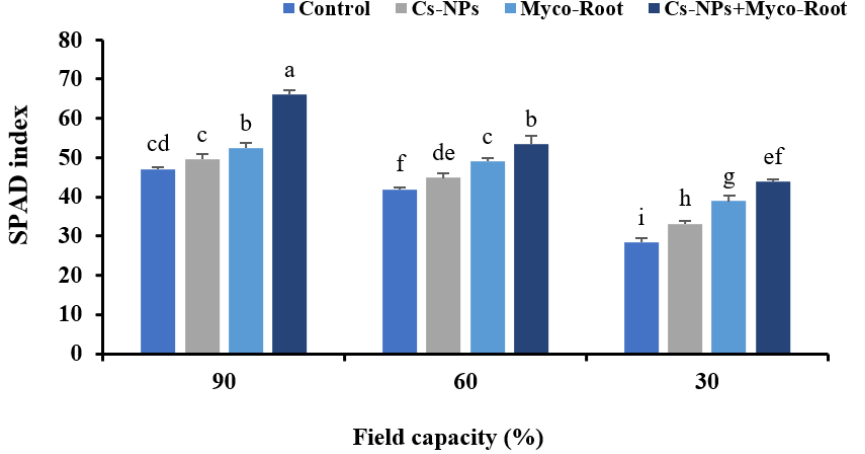
Figure 1. The SPAD index of L. iberica in different fertilizer sources and at different irrigation levels. Different letters indicate significant differences at the 5% level according to LSD test.